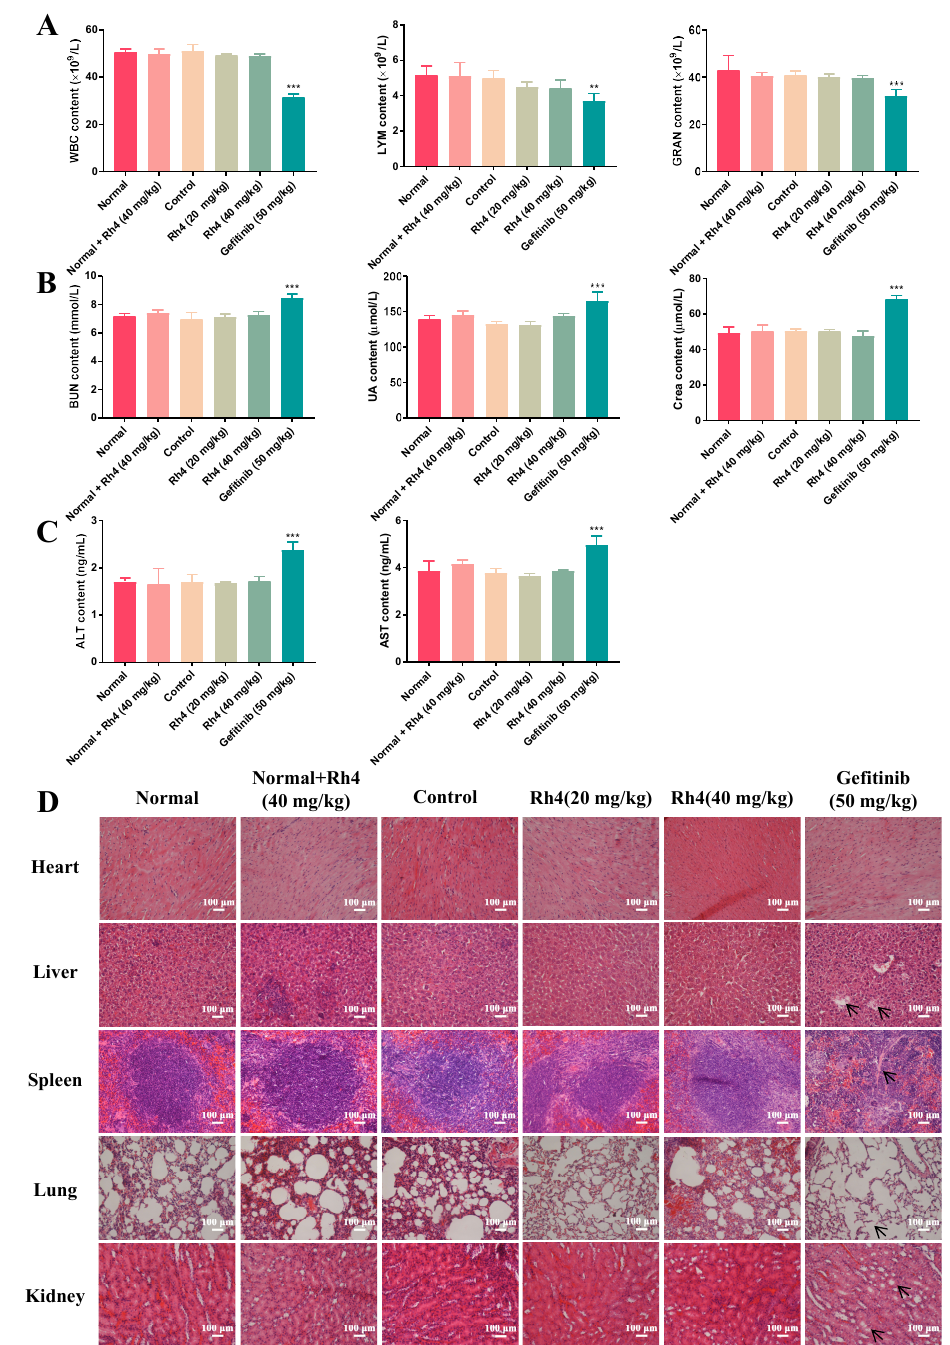
Figure 2. Ginsenoside Rh4 contributed to lower number of side effect of major organs and immune function in xenograft nude mice than gefitinib. ( A ) Count of white blood cells (WBC), lymphocytes (LYM) and granulocytes (GRAN) in peripheral blood of mice in each group were measured using automatic hematology analyzer. The levels of ( B ) renal function parameters (BUN, UA and Crea) and ( C ) liver function parameters (ALT and AST) in the serum from each group. ( D ) H & E staining of major organs in each group including the heart, liver, spleen, lungs and kidneys. Rh4 caused few damages to major organs of nude mice. There were 5 mice in each group. Scale bars = 100 µ m. Data are presented as means ± SD of three independent experiments, ** p < 0.01 and *** p < 0.001 compared with the